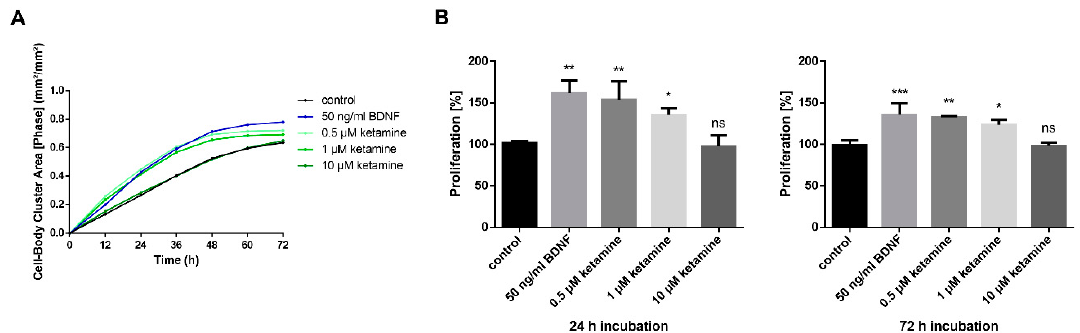
Figure 3. Concentration-dependent e ff ects of ketamine on the proliferation in Ro-iPSC NPCs. ( A ) Real-time quantitative analysis of cell proliferation of an additional NPC cell line. Confluency of cells was determined with IncuCyte ® software indicated as Cell-Body Cluster Area. NPCs were treated with di ff erent concentrations of ketamine (0.5; 1 and 10 µ M) or 50 ng / mL BDNF as a positive control. ( B ) The e ff ect on proliferation is shown at the selected time points of 24 and 72 h compared to 0.01% dimethyl sulfoxide (DMSO) control, respectively. The data represent the means of three independent experiments. Error bars were calculated using ± SEM, and p-values were calculated against the DMSO control.